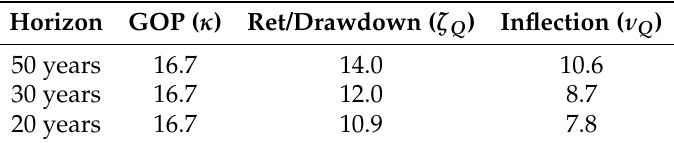
Table 2. Leverage level for 15-year